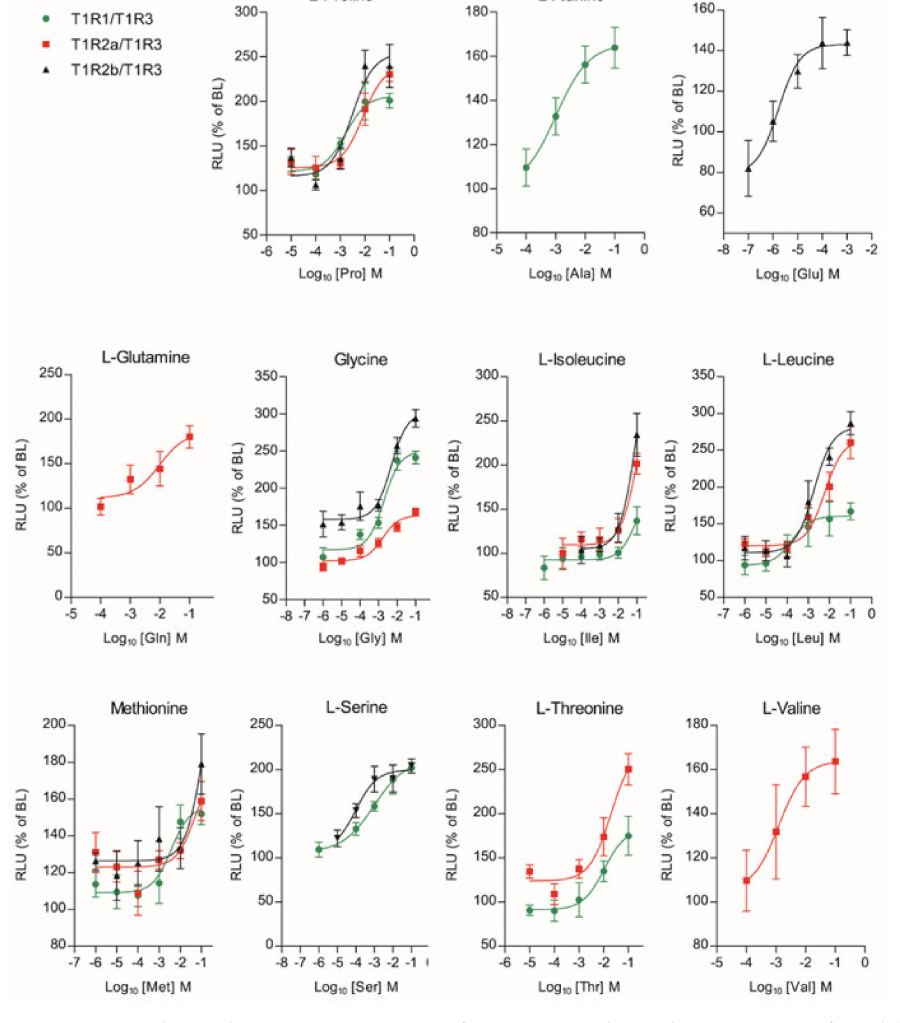
Figure 6. Amino acid Log-dose response curves of activation in heterologous co-transfected (Cl.3) cells with saT1R1 / 3 (green dots), saT1R2a / 3 (red squares) and saT1R2b / 3 (black triangles) heterodimers. Evaluation of L-AA responses was based on the RLU mean ± SEM of four independent determinations normalized to the mean response of the same transfections stimulated with reduced assay medium (Basal Medium Eagle w / o L-glutamate (BME) + 1% FBS), and expressed as the percentage relative to basal levels